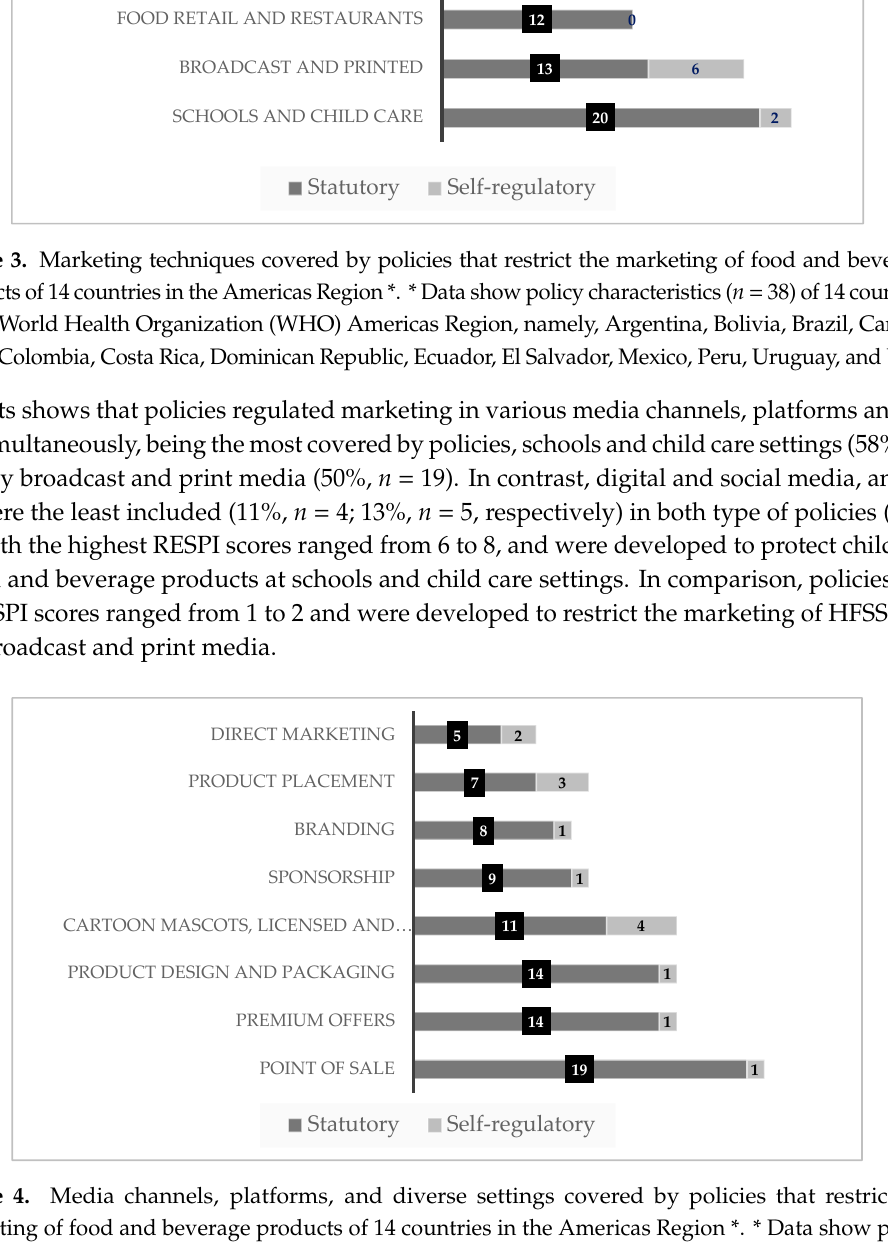
Figure 4. Media channels, platforms, and diverse settings covered by policies that restrict the marketing of food and beverage products of 14 countries in the Americas Region *. * Data show policy characteristics ( n = 38) of 14 countries of the World Health Organization (WHO) Americas Region, namely, Argentina, Bolivia, Brazil, Canada, Chile, Colombia, Costa Rica, Dominican Republic, Ecuador, El Salvador, Mexico, Peru, Uruguay, and